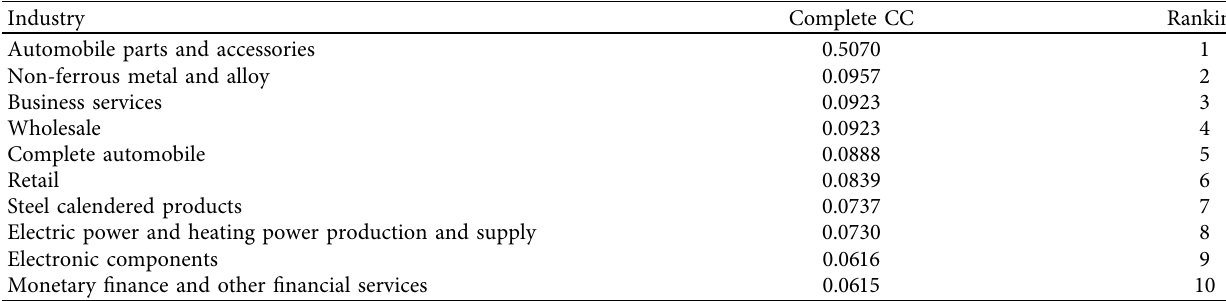
Table 5: Top 10 industries for complete